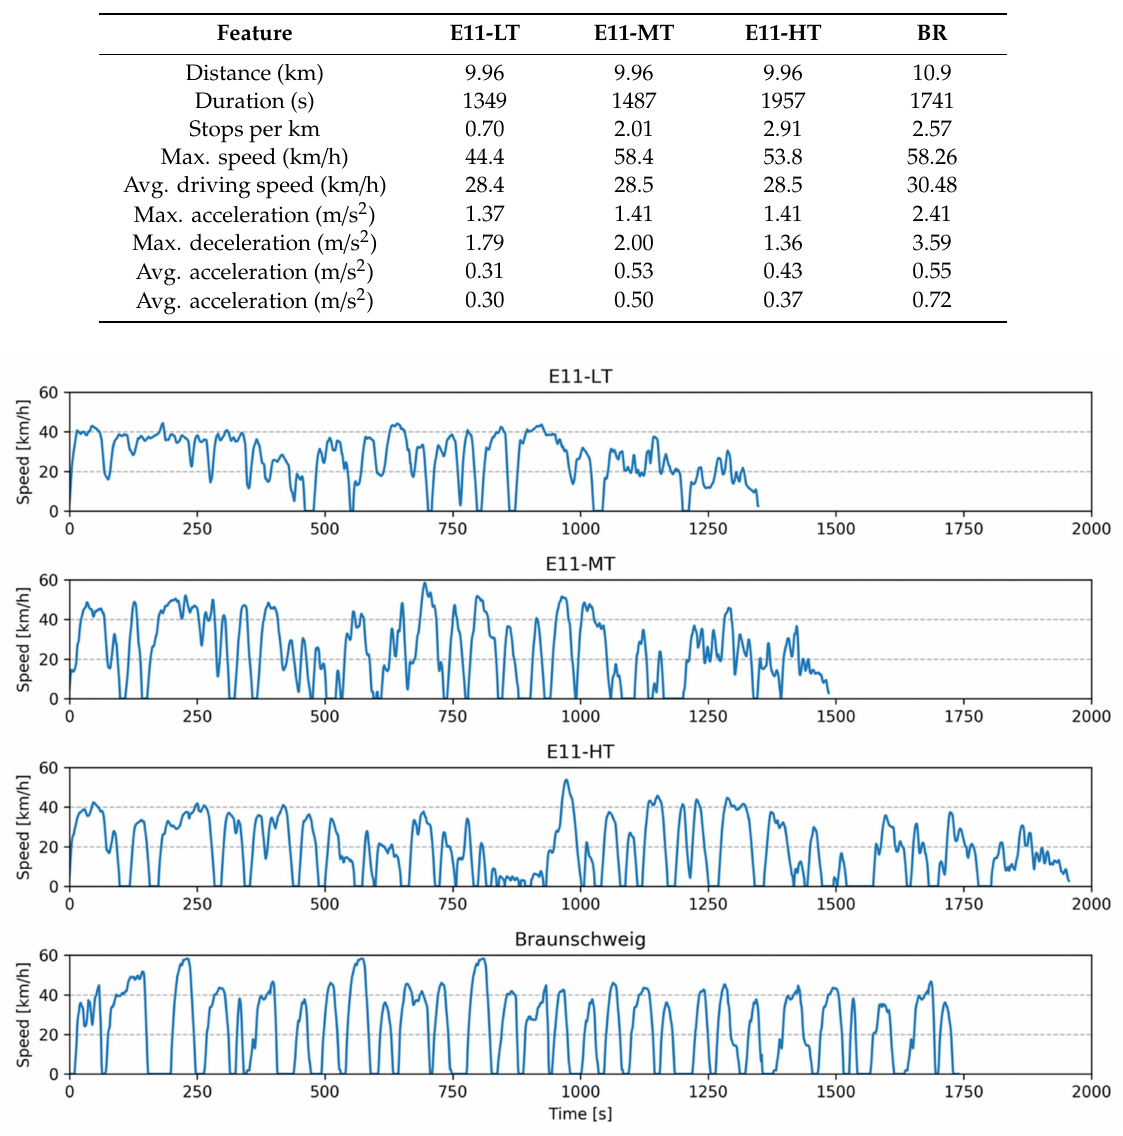
Table 2. Braunschweig (BR) and three Espoo 11 (E11) cycle characteristics.